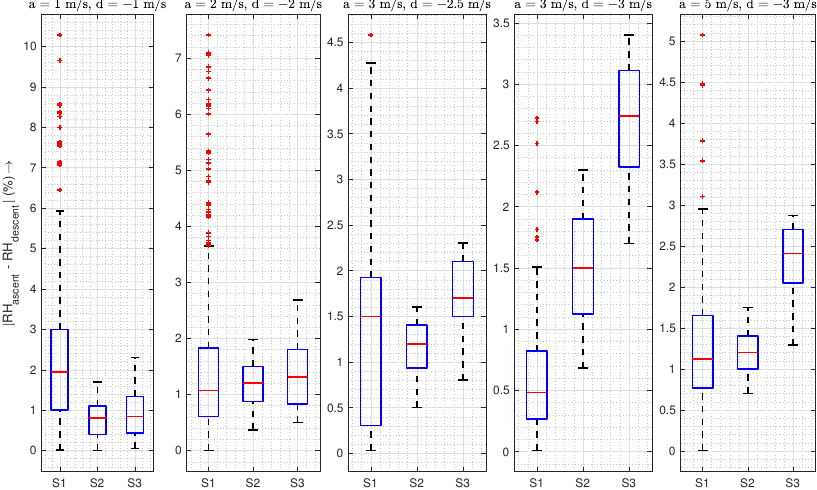
Figure 10. The box plot summarizes Figure 9 by showing the absolute (ascent − descent) temperature and humidity differences for 10 consecutive flights conducted over a period of 60 min (7/18/2018 7:21 pm UTC–8:20 pm UTC) at different ascent ( a ) and descent ( b ) speeds mentioned in the title of each subplot. Multiple flights at the same speed are grouped and plotted together. The sky was mostly sunny with cumulonimbus clouds, and the ground wind was 4–5 m/s from the